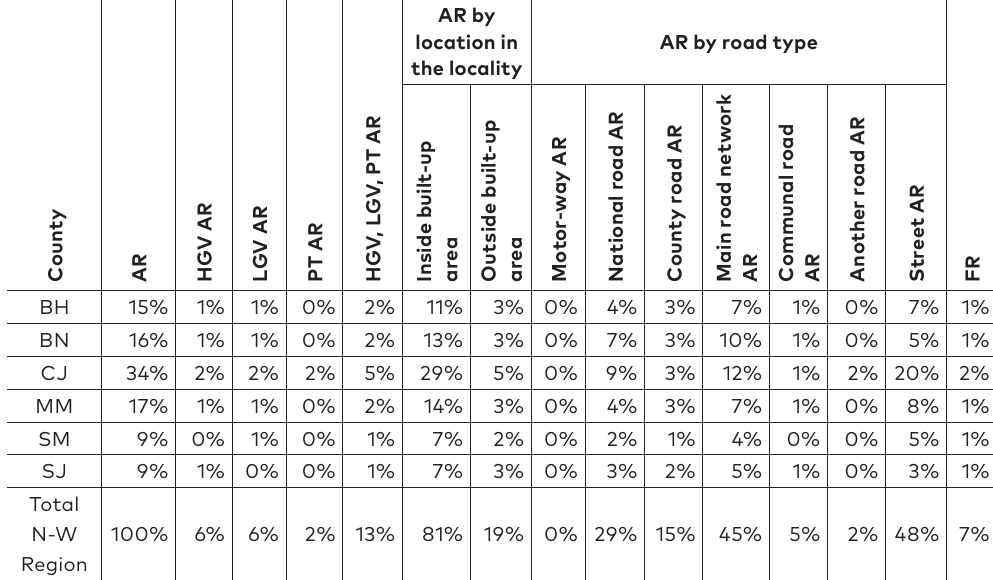
Table 4. Accident rate and fatality rate by county (source: author*,